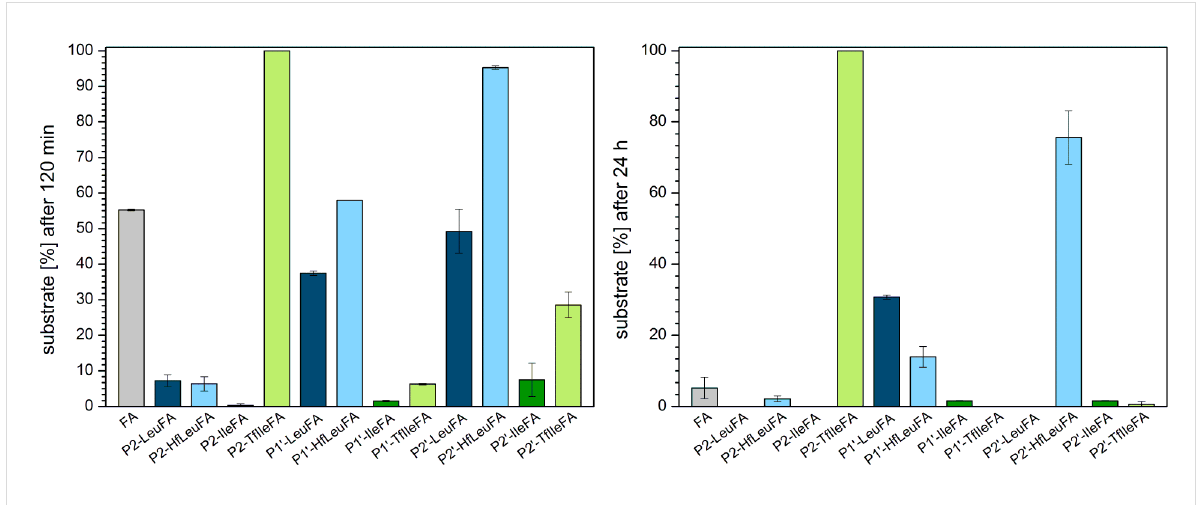
Figure 4: Percentage of substrate remaining after incubation for 120 min (left) and 24 h (right) with pepsin in 10 mM acetate buffer, pH 4.0, at 30 °C. The data shown represent the average of three independent measurements. Errors are derived from the standard deviation.